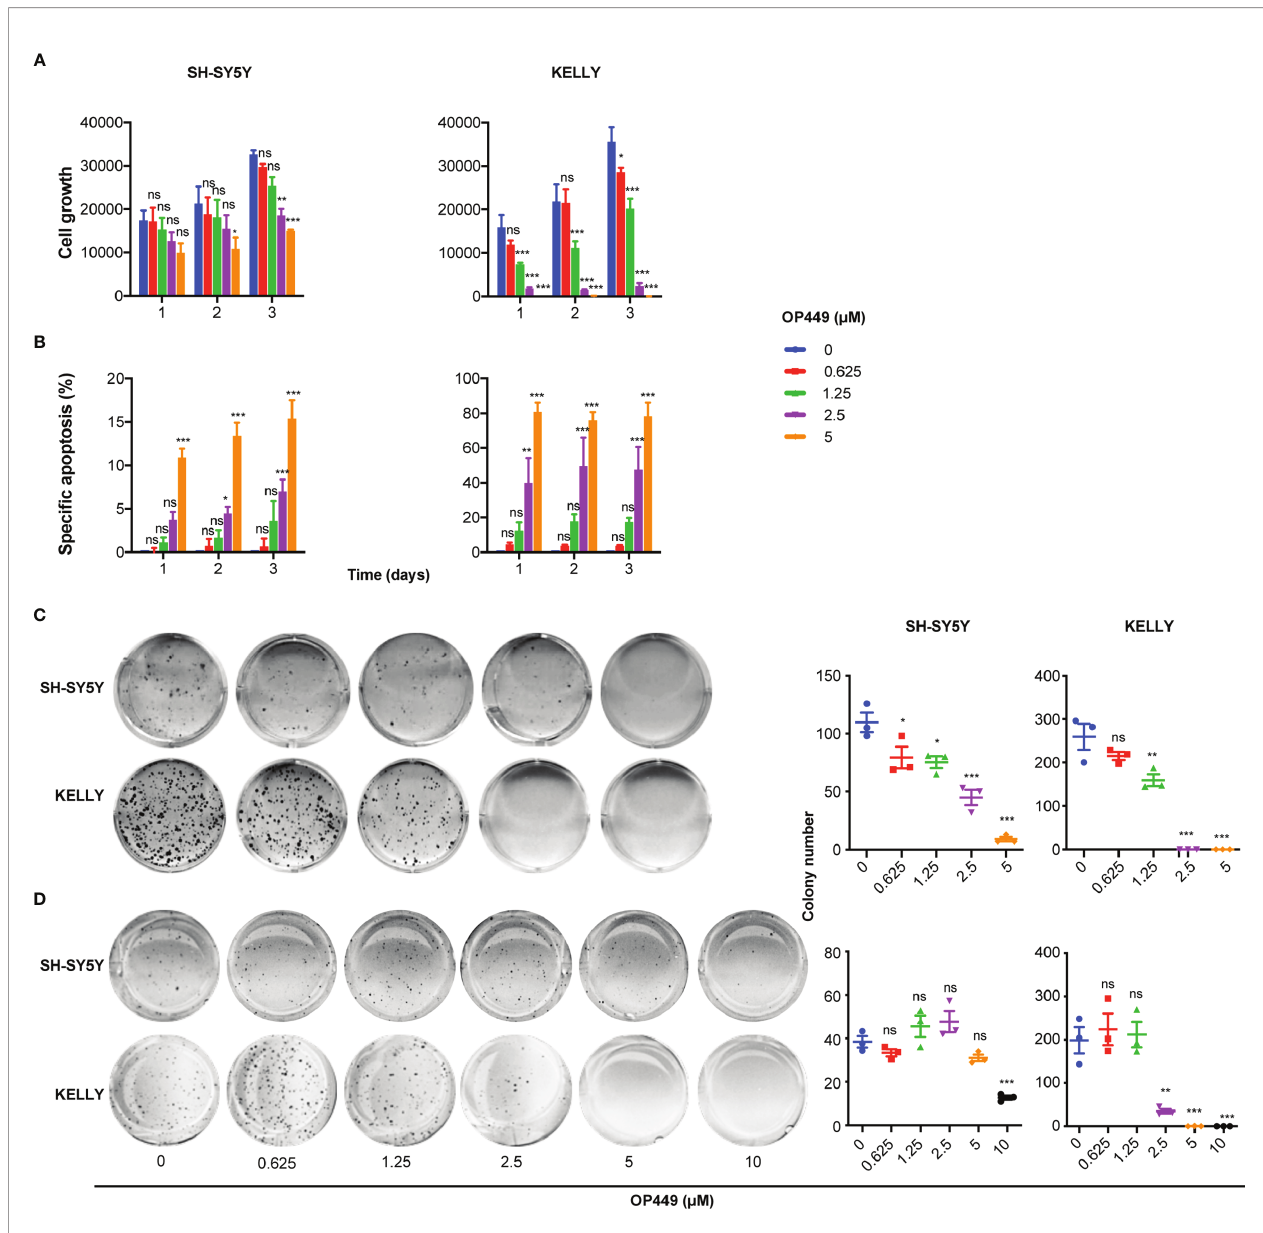
FIGURE 4 | OP449 inhibits aggressiveness of SH-SY5Y and KELLY cells. MYCN -non ampli fi ed SH-SY5Y and MYCN -ampli fi ed KELLY cells were treated with increasing concentrations of OP449. (A) Inhibition of cell growth. With the use of fl ow cytometry dead, i.e., propidium iodide-positive, cells were excluded, and viable cells were counted. Shown is the number of living cells counted at different time points after start of treatment. (B) Inhibition of apoptosis. Apoptosis was determined by enumerating hypodiploid propidium iodide-stained nuclei using fl ow cytometry. Shown is the speci fi c percentage of apoptotic nuclei. (C) Inhibition of clonogenicity. Cells were grown in plastic dishes and treated on days 1 and 3 after seeding. After 2 weeks, cells were stained with crystal violet, and colonies were counted. (D) Inhibition of anchorage-independent growth. Cells were grown in soft agar and treated on days 1 and 3 after seeding. After 2 weeks, cells were stained with crystal violet, and colonies were counted. Experiments were repeated three times. Data are expressed as means ± SEM of the means of triplicates of each independent experiment and are analyzed by two-way ANOVA test. * p < 0.05, **p < 0.01, ***p < 0.001; ns, not signi fi